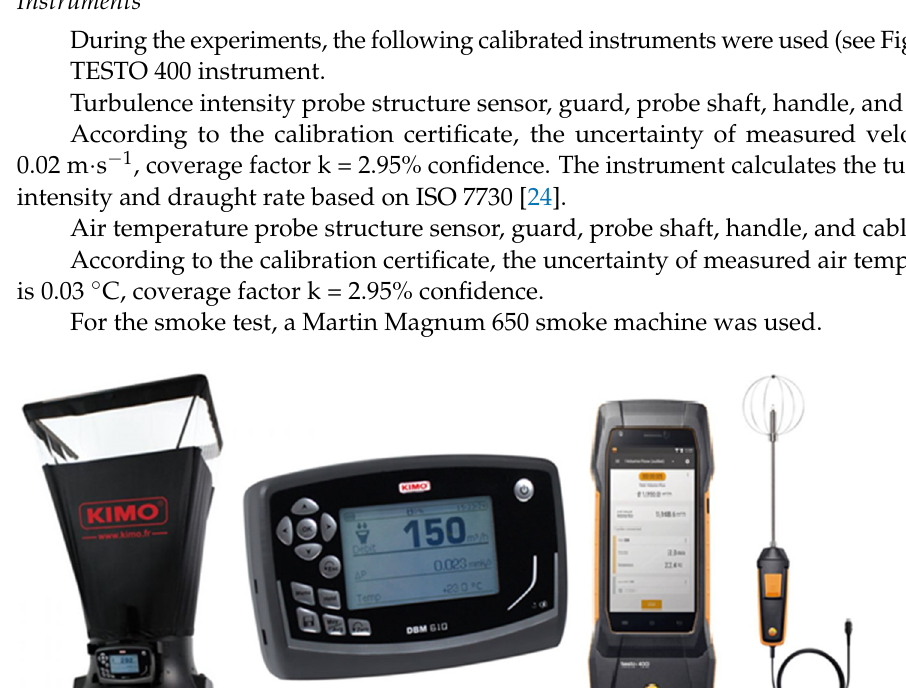
Figure A2 . Air Flow pattern .